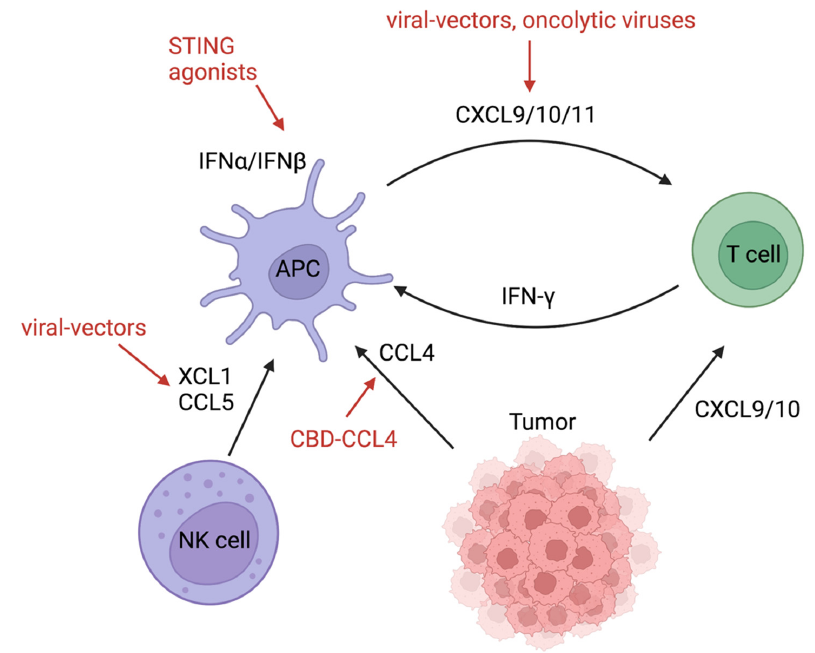
Figure 3. Chemoattraction in the tumor microenvironment. Tumor-derived CCL4 can attract Batf3 DCs and CXCL9/10 can recruit cytotoxic T cells to the tumor microenvironment. Natural Killer Cells attract Batf3 DCs via XCL1 and CCL5. CCL4 can be administered with a fusion protein consisting of CCL4 and the collagen-binding domain (CBD) of von Willebrand factor and XCL1 with a viral- vector. Batf3 DCs can produce CXCL9/10/11 and recruit CTLs. In turn, IFN- γ produced by CTLs